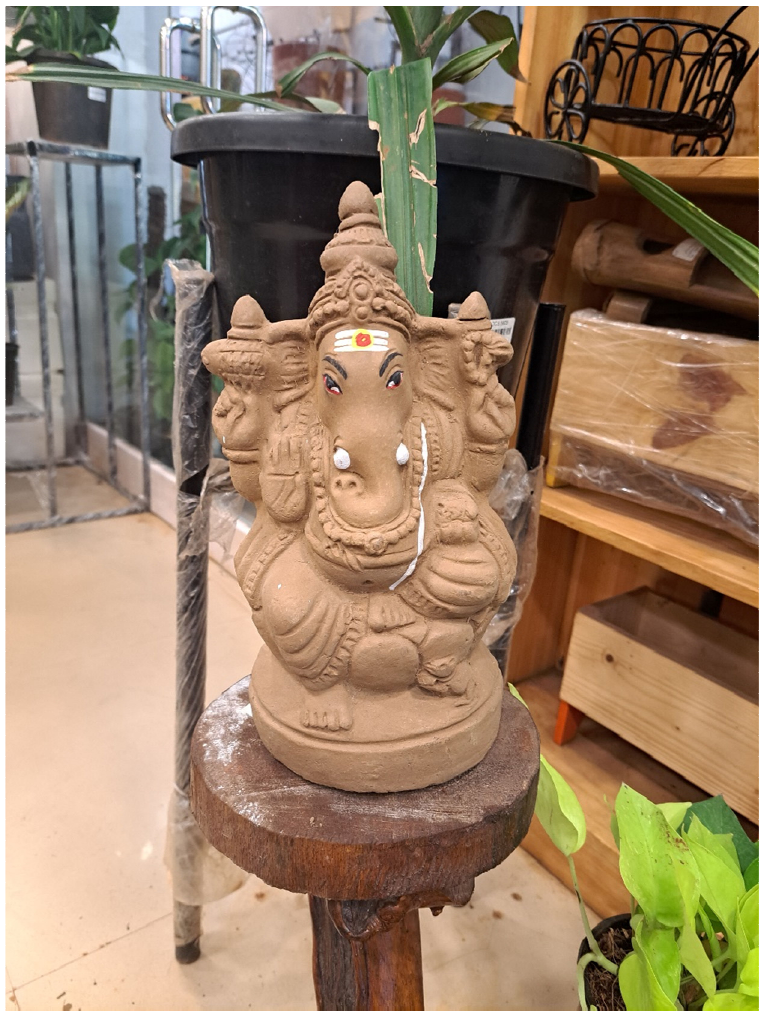
Figure 11. Seed-inside clay Ganesha sold at Harith Tharang, a plant nursery in T Nagar. Picture taken by author, 2 September 2022, Chennai.